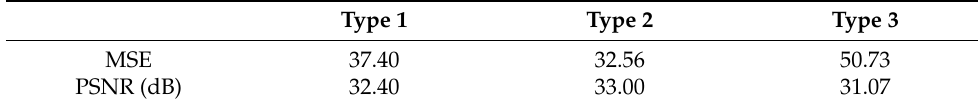
Table 1. Signal-to-noise ratio and contrast of input